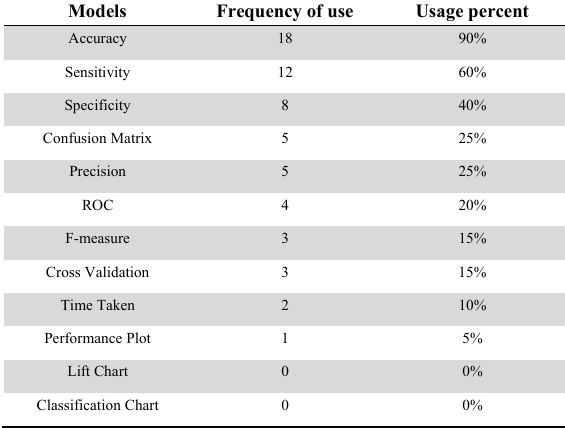
Comparison of the evaluation methods